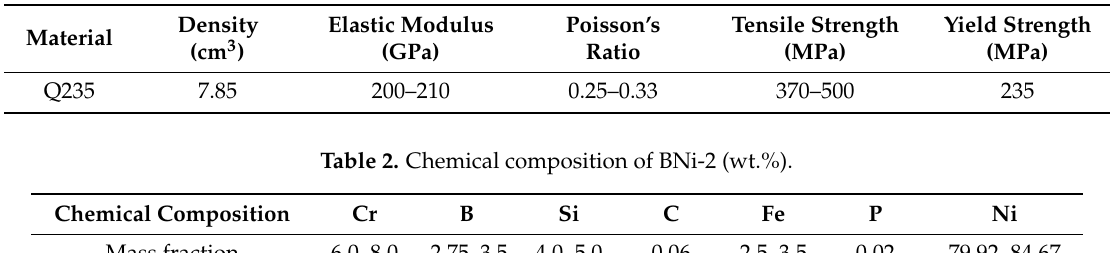
Table 1. Mechanical characteristics of Q235 carbon steel.